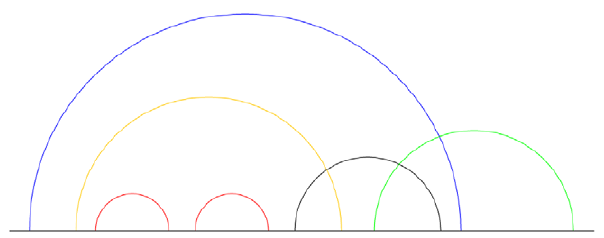
Figure 2. Extraction of nested base pairs. Starting from the leftmost base pair (blue arc), the determination of non-nested arcs is in the order of: blue, green, black and orange. The two nested base pairs (red arcs) are extracted as two irreducible components.